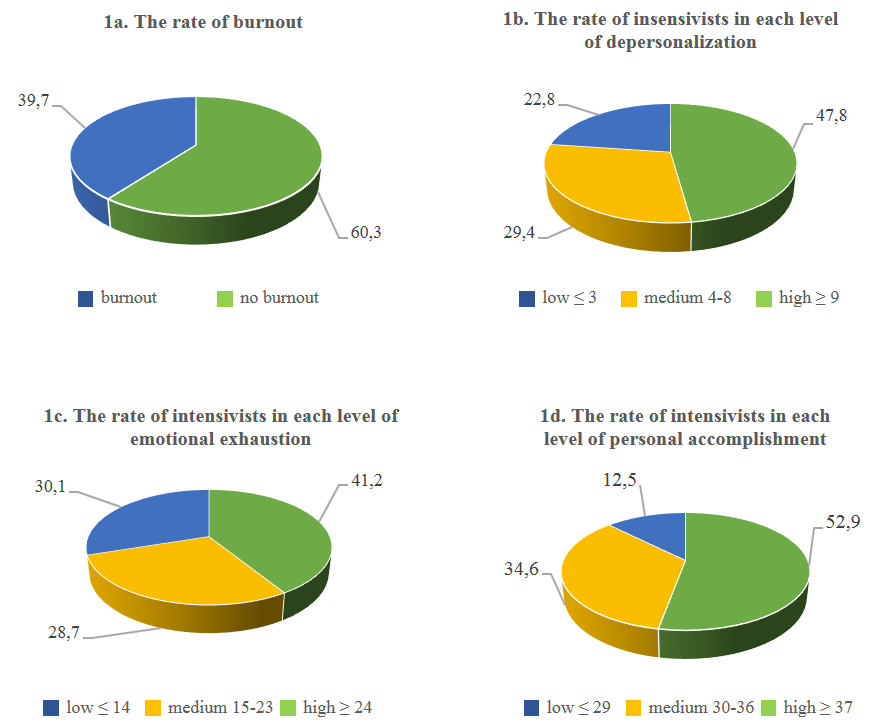
Figure 1. The rate of burnout and the rate of intensivists in each level of the three dimensions of burnout (variables are expressed as percentages).